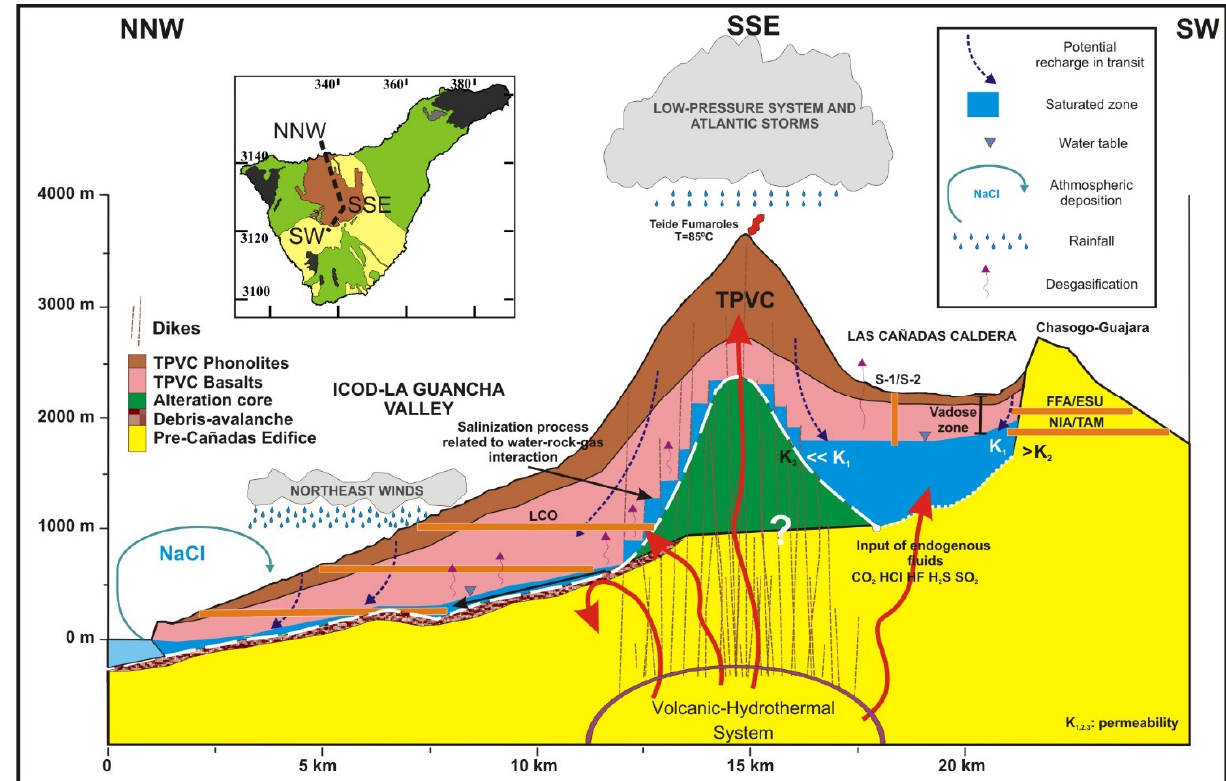
Figure 2. Conceptual hydrogeological model of Las Cañadas aquifer system, including Las Cañadas Caldera, Teide-Pico Viejo Volcanic Complex (TPVC), and Icod-La Guancha Valley areas, after [33]. Main hydrogeological processes affecting groundwater dynamics and hydrochemistry are